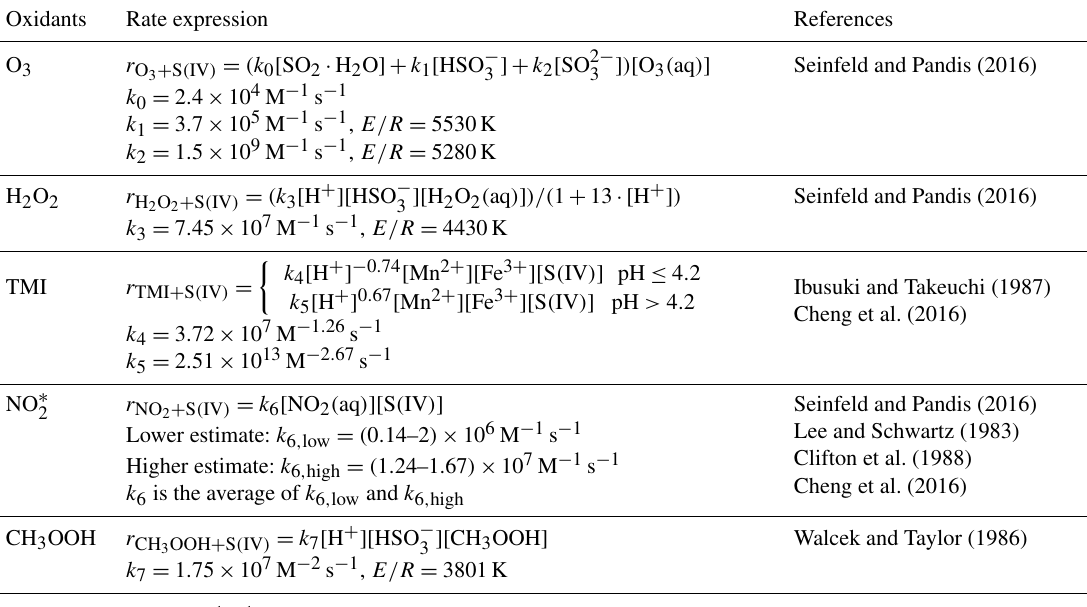
Table 1. Rate expressions and rate constants for the S(IV) oxidation reactions in the aerosol water. Oxidants Rate